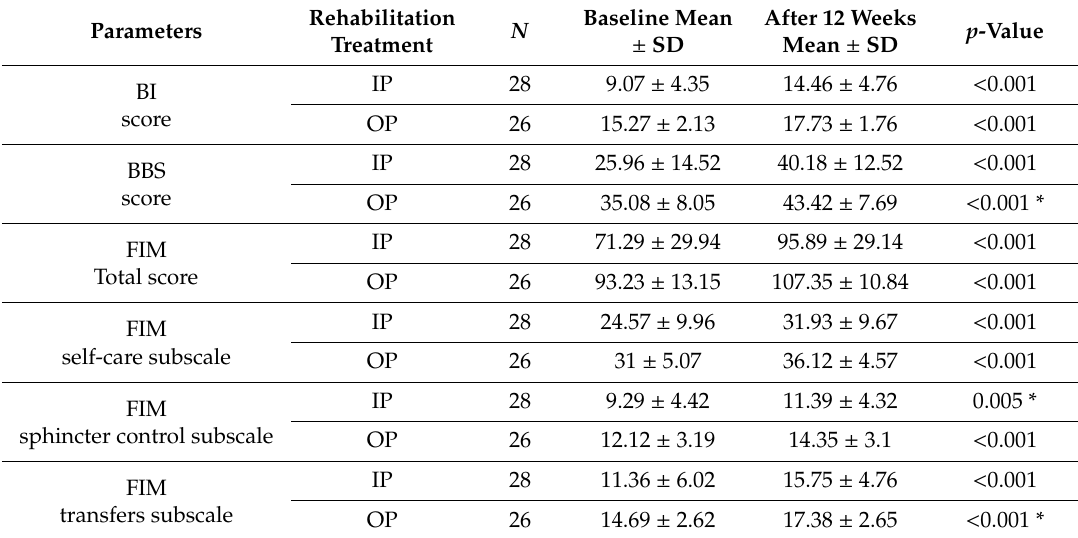
Table 3. Analysis of the physical functioning results before and after rehabilitation treatment in inpatient and outpatient brain tumor patient